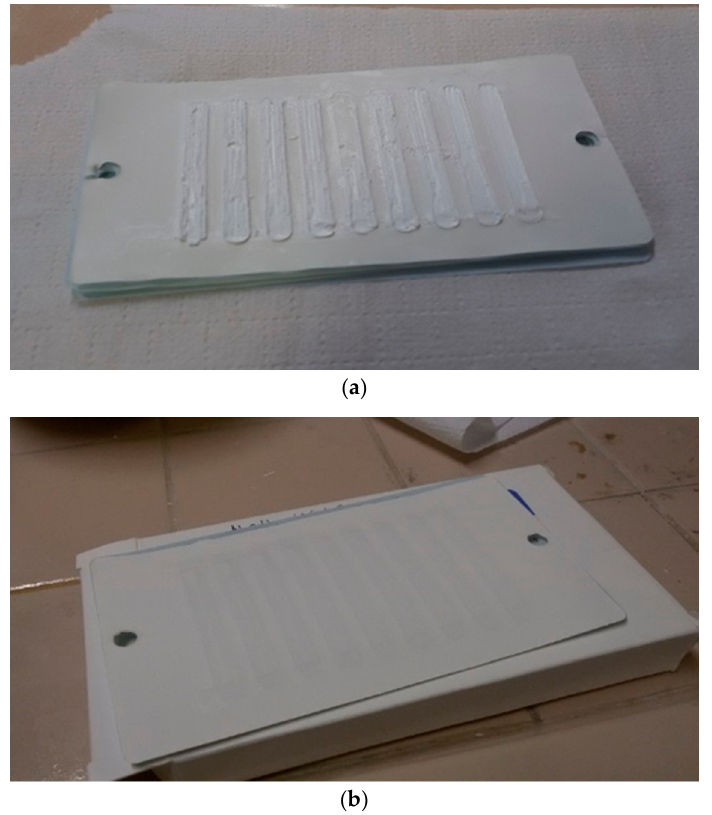
Figure 5. Dry membrane after run#5 ( a ) and run#6 ( b ).